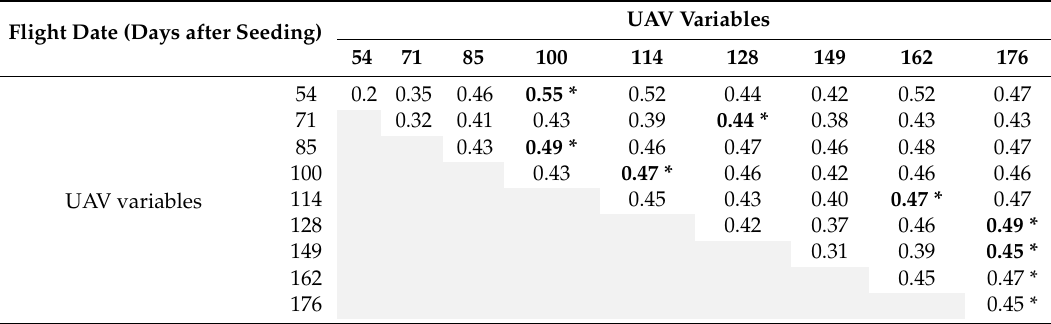
Table 2. Modeling the final AGB with the combination of UAV variables (vegetation indices and height) from two flight surveys. Each cell represents the R-square (sum of the two pls components) associated with the final AGB model adjusted with the combination of UAV variables from two flight dates. For every flight date, the best combination is bolded and marked with a * character. Flight Date (Days after Seeding)